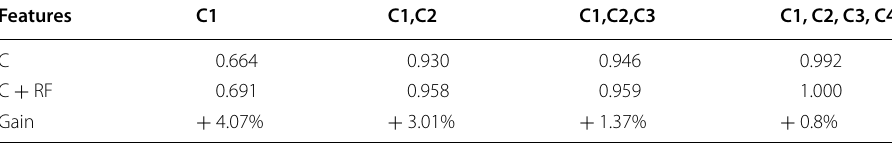
C i checkpoints added cumulatively RF risk flag added to each